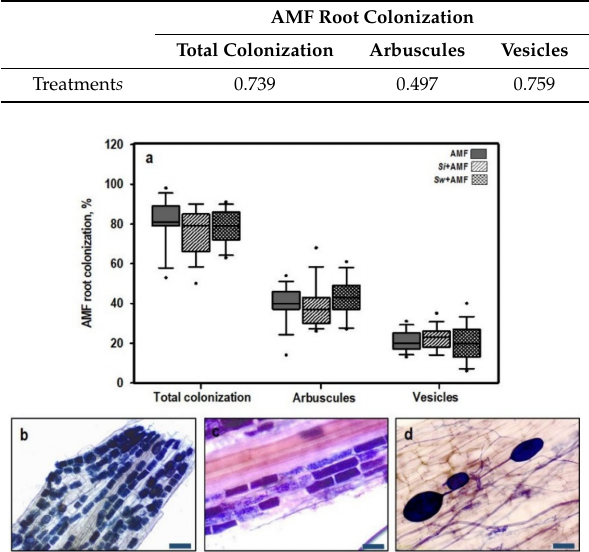
Figure 1. AMF root colonization in tomato roots nine weeks after transplanting including the % total root colonization, % arbuscules, and % vesicles ( a ). There were no significant differences detected between thetreatments(ANOVA, p < 0.05, n = 15). Differentpartsshowinganintenselycolonizedrootpiece( b ),arbuscules ( c ), and vesicles ( d ) in the tomato roots. Roots were stained using the ink-vinegar method of Vierheilig et al. [37]. Scale bar: 100 µ m ( b ) and 50 µ m ( c , d